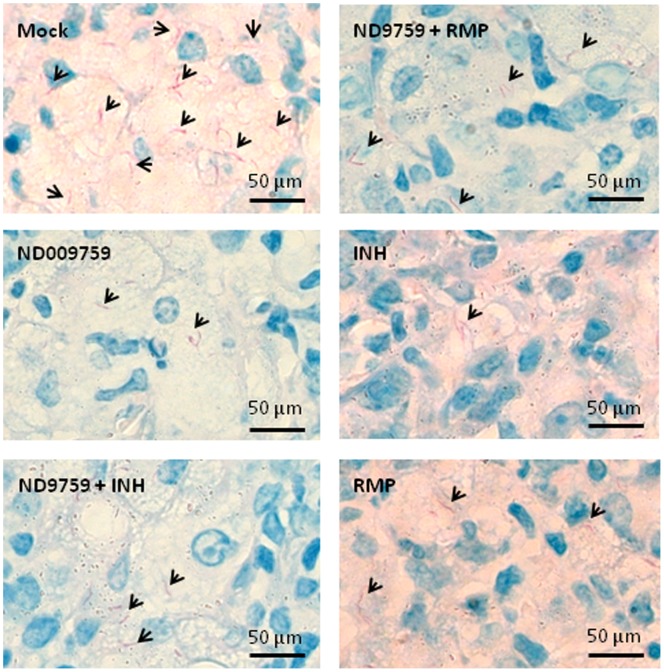
Acid-fast staining of lung sections from M. tuberculosis-infected Balb/c mice (n = 5) following treatment with 80% aqueous propylene glycol (vehicle control) or chemotherapy with drugs as indicated.Magnification (630X). Acid fast bacilli indicated by arrows.